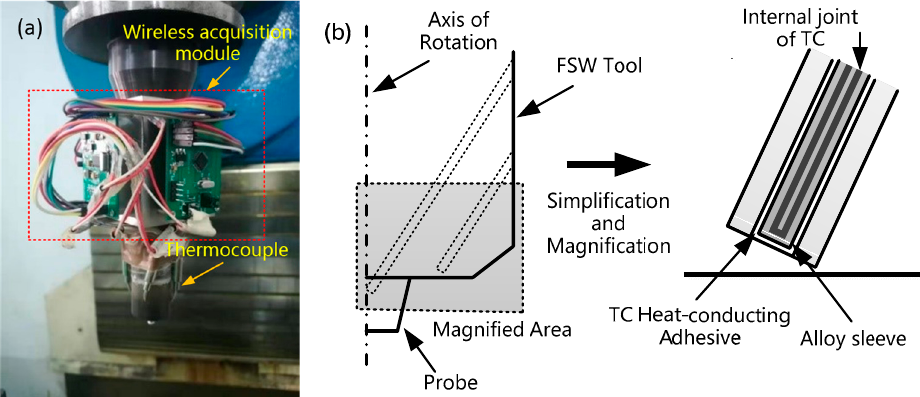
Figure 4. Wireless temperature measurement system. ( a ) Assembly of wireless temperature measurement system; ( b ) thermocouple temperature monitoring diagram.